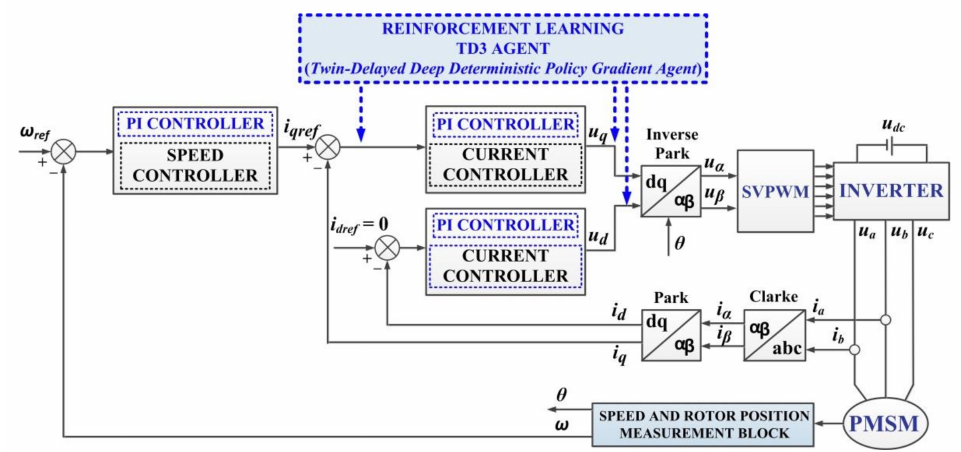
Figure 2. Block diagram for FOC-type control of the PMSM based on PI-type controllers using